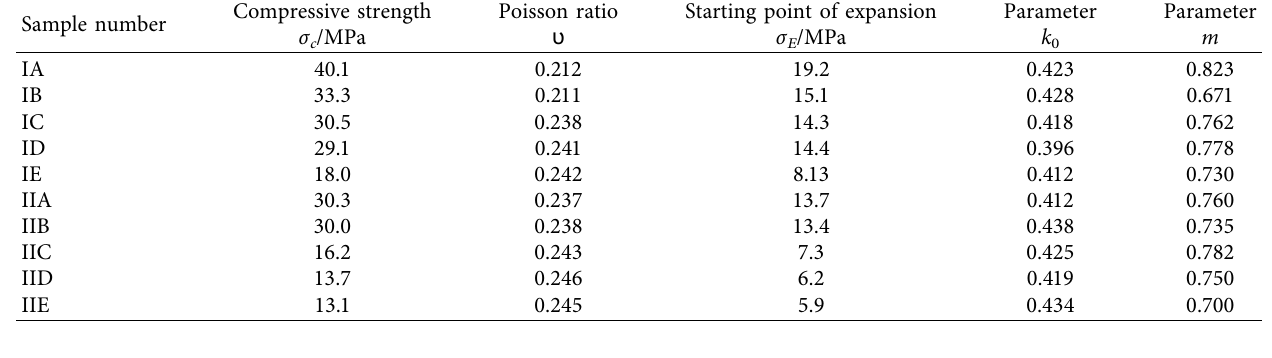
Table 5: Uniaxial compression test results and material parameters of F-T sandstone.